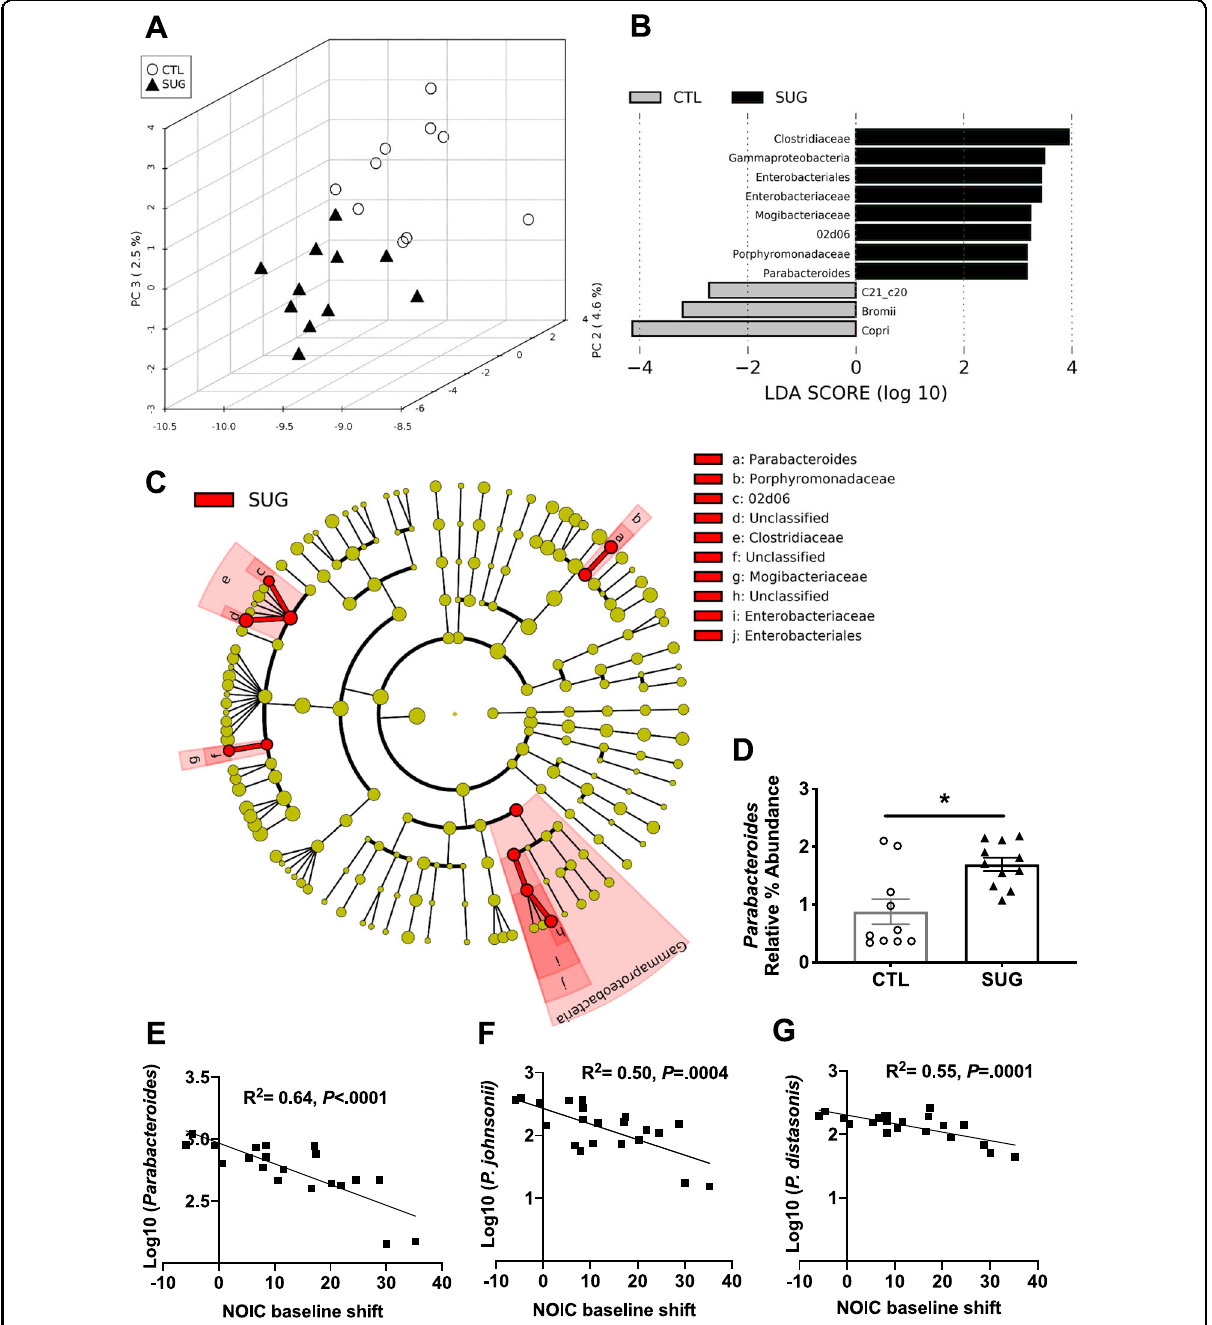
Fig. 2 Effect of adolescent sugar consumption on the gut microbiome in rats. A Principal component analysis showing separation between fecal microbiota of rats fed early life sugar or controls ( n = 11, 10; dark triangles = sugar, open circles = control). B Results from LEfSe analysis showing Linear Discriminate Analysis (LDA) scores for microbiome analysis of fecal samples of rats fed early life sugar or controls. C A cladogram representing the results from the LEfSe analysis with the class as the outermost taxonomic level and species at the innermost level. Taxa in red are elevated in the sugar group. D Relative % abundance of fecal Parabacteroides are signi fi cantly elevated in rats fed early life sugar ( P < 0.05; n = 11, 10, two-tailed, type 2 Student ’ s t test). E Linear regression of log normalized fecal Parabacteroides counts against the shift from baseline performance scores in the novel object in context task (NOIC) across all groups tested ( n = 21). E – G Linear regression of the most abundant fecal Parabacteroides species against shift from baseline performance scores in NOIC across all groups tested ( n = 21). * P < 0.05; data are shown as mean ±